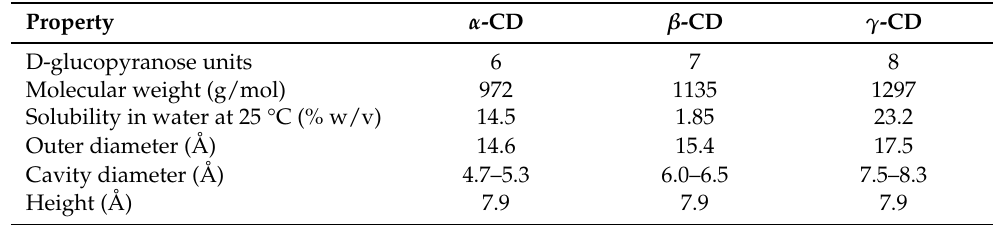
Table 1. Characteristics of native cyclodextrins.